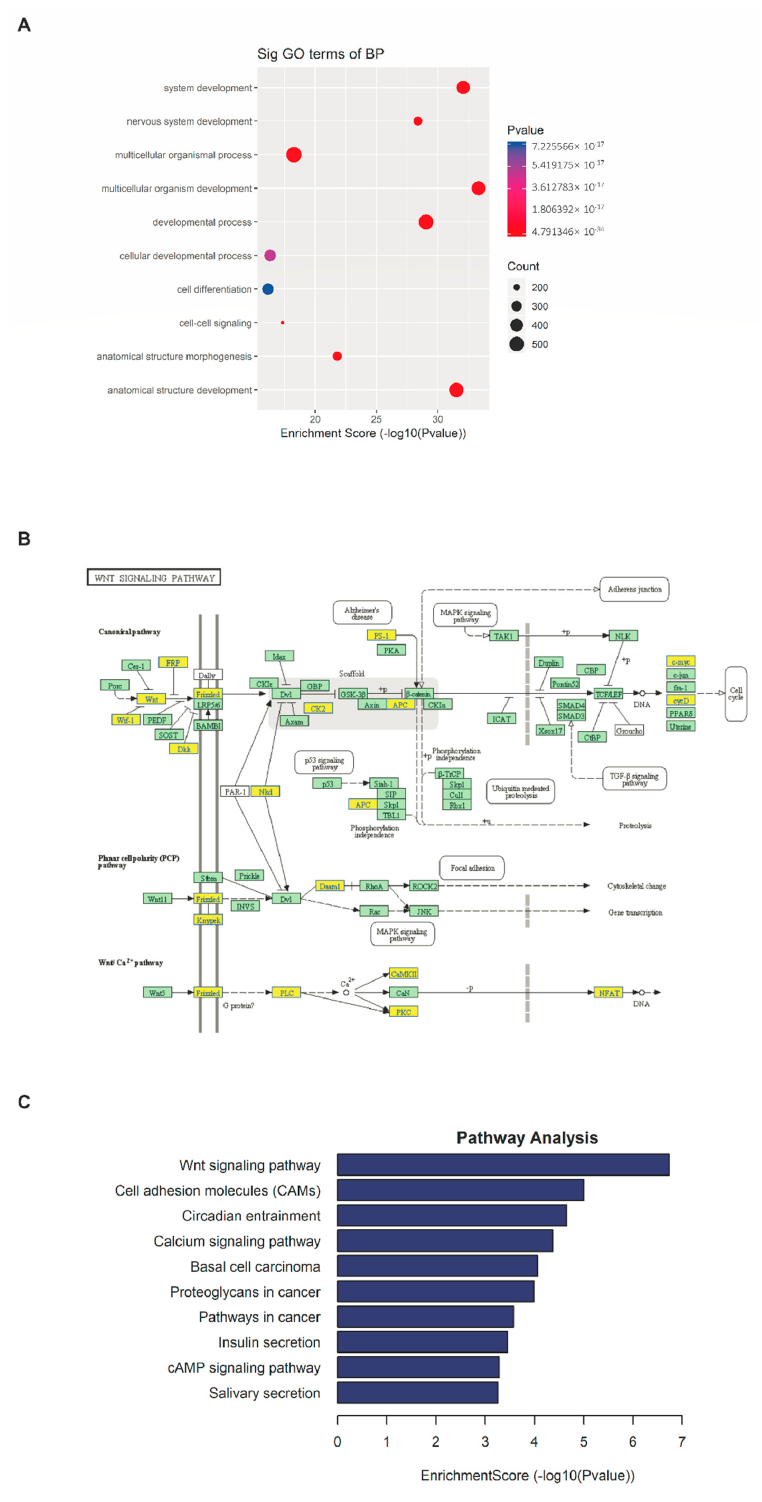
Figure 3. m 6 A − seq identifies transcripts with altered methylation in psoriasis vulgaris. ( A ) The top 10 Gene Ontology terms were significantly enriched for the hypomethylated genes in skin samples derived from patients with psoriasis vulgaris ( n = 4) and healthy controls ( n = 4). ( B ) Diagram of the Wnt signaling pathway with genes affected by m 6 A. Hypomethylated genes are marked in yellow and nonmethylated genes are marked in green. The diagram is based on KEGG annotations. ( C ) The top 10 significantly enriched pathways for the hypomethylated genes in skin samples derived from patients with psoriasis vulgaris ( n = 4) and healthy controls ( n =